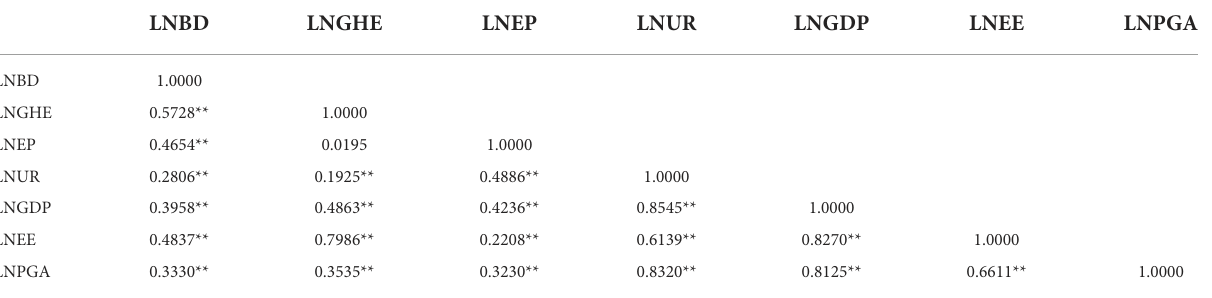
TABLE 2 Pearson correlation analysis between independent